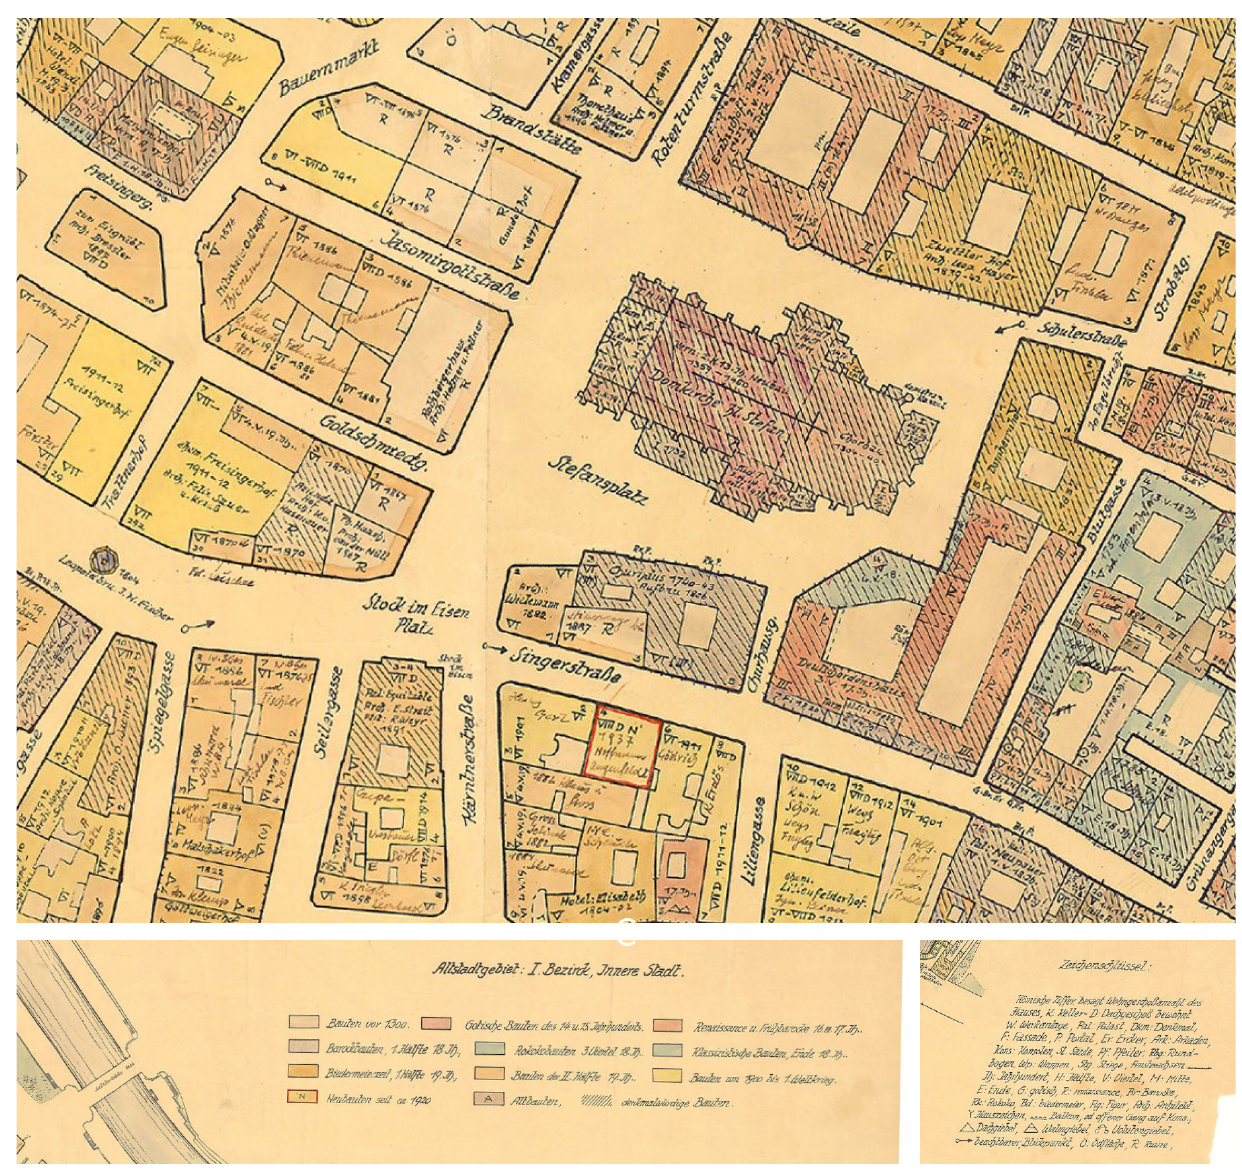
Figure 3. Adalbert Klaar’s building age plan for Vienna’s Inner City (1948), with details and legends. Source: Klaar (1948). 190 historic towns and villages (Klaar, 1959, pp. 55–61) under the direction of Adalbert Klaar. These maps not only show the ages of the buildings but also make a statement regarding the desirability of protecting